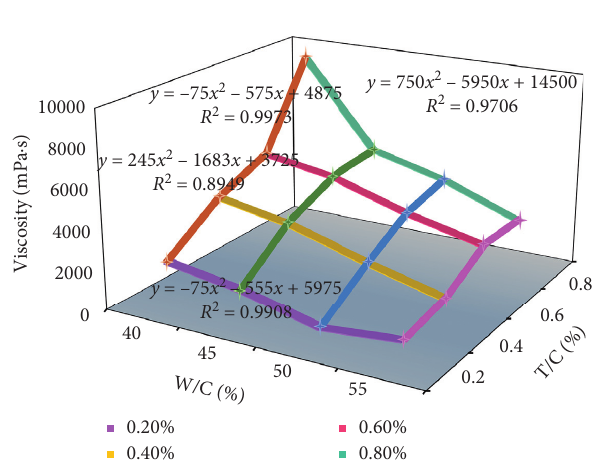
Figure 7: W/C interaction with